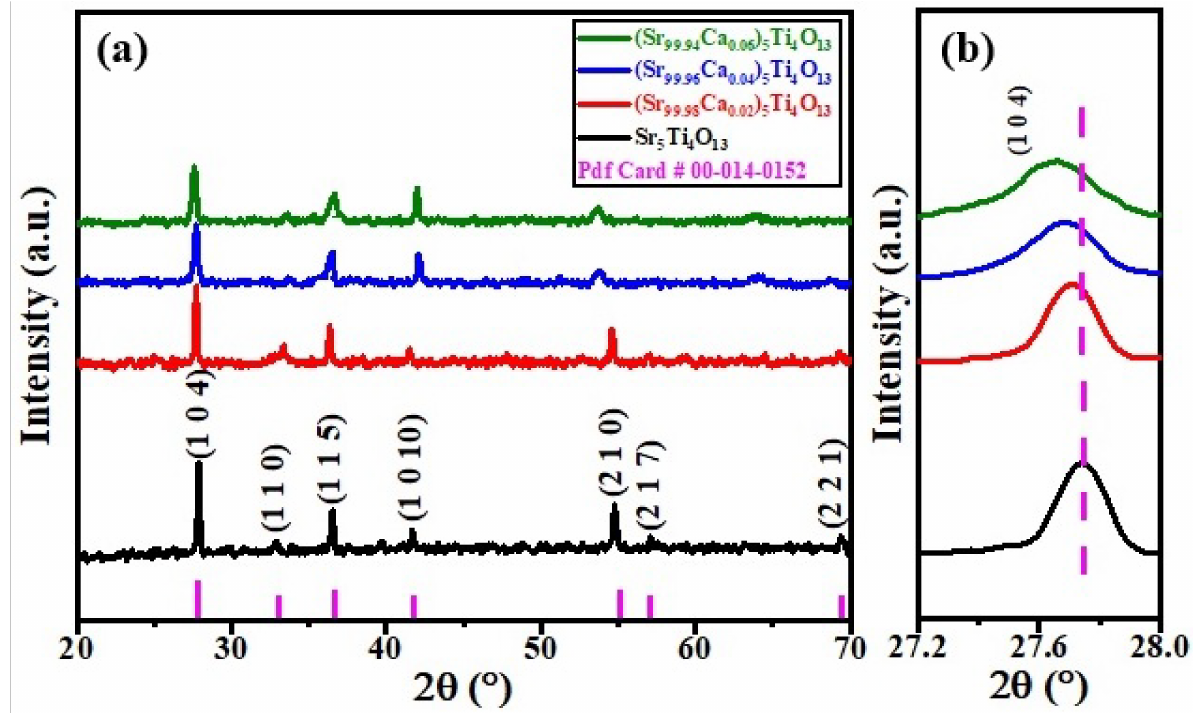
Figure 1. ( a ) XRD pattern of (Sr 1 − x Ca x ) 5 Ti 4 O 13 , 0 ≤ x ≤ 0.06 sintered ceramics ( b ) zoomed view of peak (1 0 4) shifted toward the lowest angle.